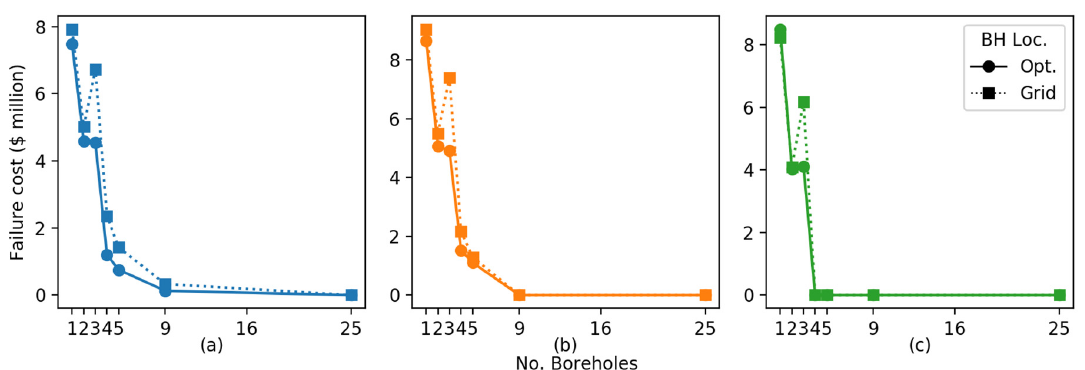
Figure 9. Failure cost comparison between a regular grid of boreholes (Grid) and optimal locations (Opt.) in a two layer soil with boundary standard deviation of 4 m and ( a ) 25 piles, ( b ) 9 piles, and ( c ) 4 piles.